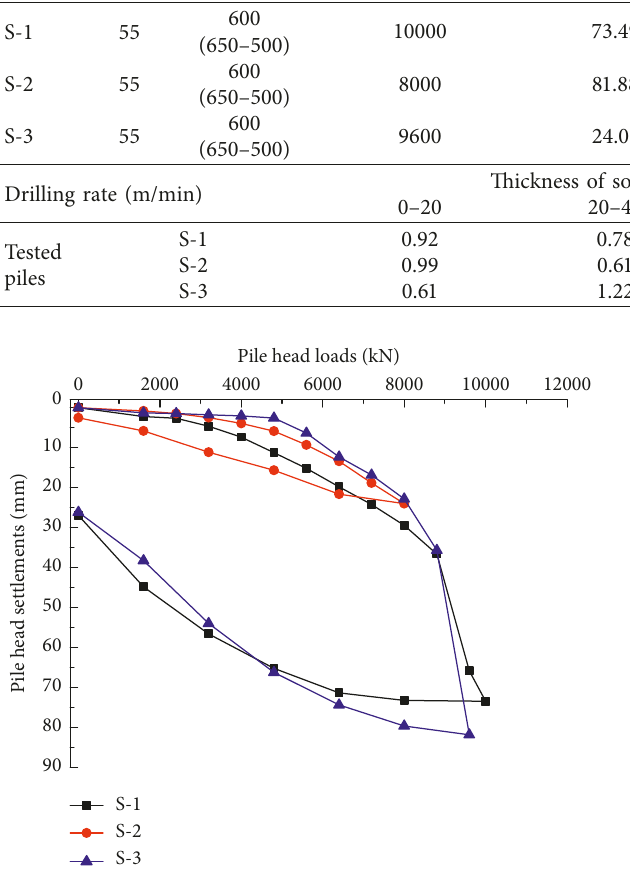
Figure 4: Load-displacement curves of tested